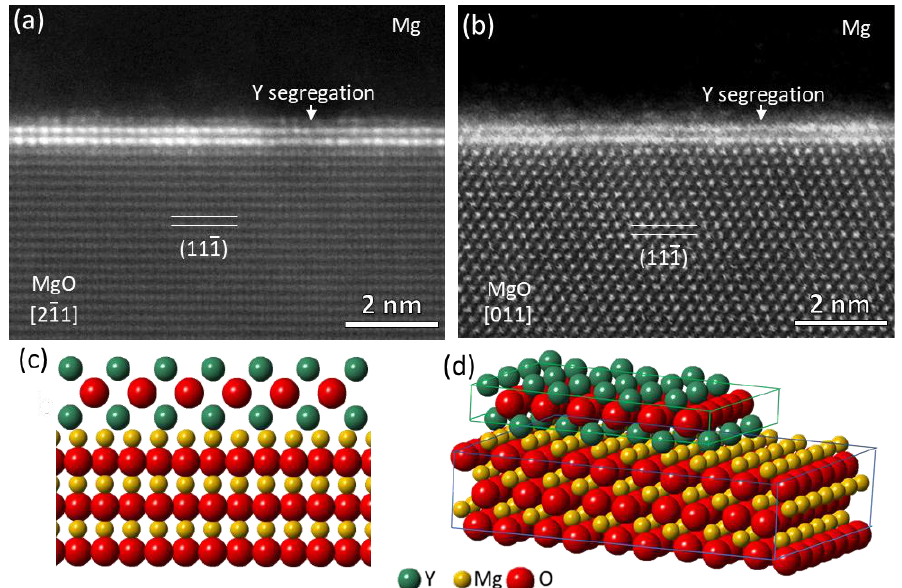
Figure 28. Nature of Y segregation layer at Mg/(1 1 1)MgO interface [28]. ( a , b ) High resolution STEM HAADF images showing interface between Mg and (1 1 1)MgO particle along ( a ) [2 1̅ 1]MgO and ( b ) [0 1 1]MgO direction respectively, where two Y-containing atomic layers with a brighter contrast are visible; and ( c , d ) schematics showing ( c ) segregated Y atoms viewed from [2 1̅ 1]MgO direction and ( d ) 3D construction of Y 2 O 3 2DC segregation layer.